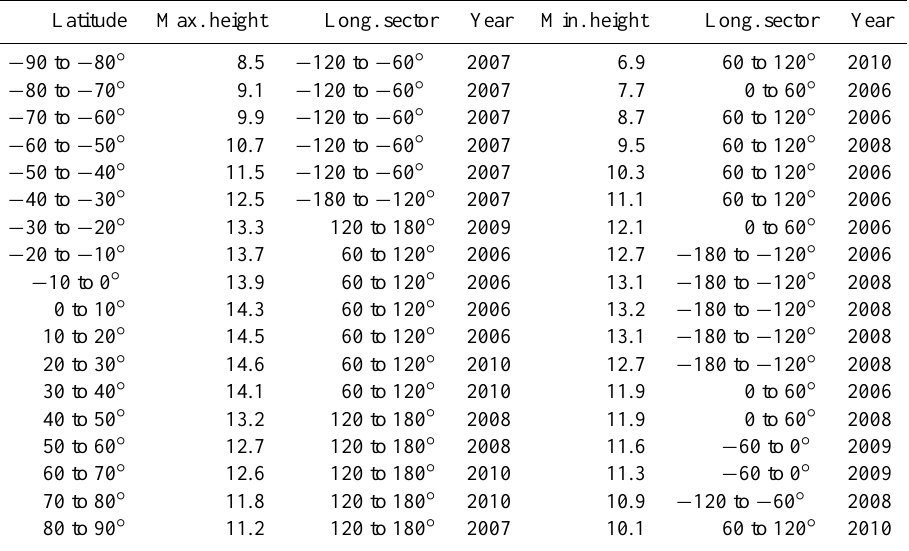
Table 3. July: maximum height, corresponding longitude sector and year and minimum height, corresponding longitude sector and year for T diff = − 0 . 1K. Latitude Max.